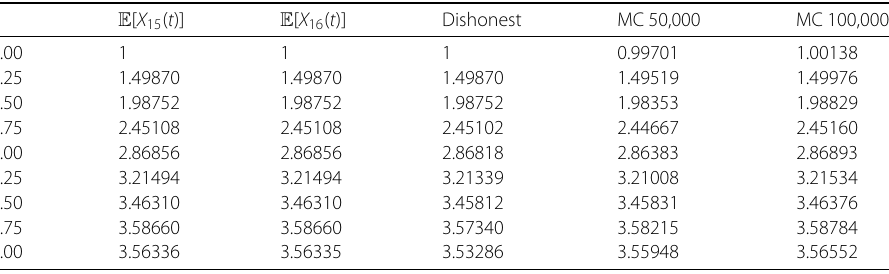
Table 1 Approximation of the expectation of the solution stochastic process. Example 4.1, assuming independent random data